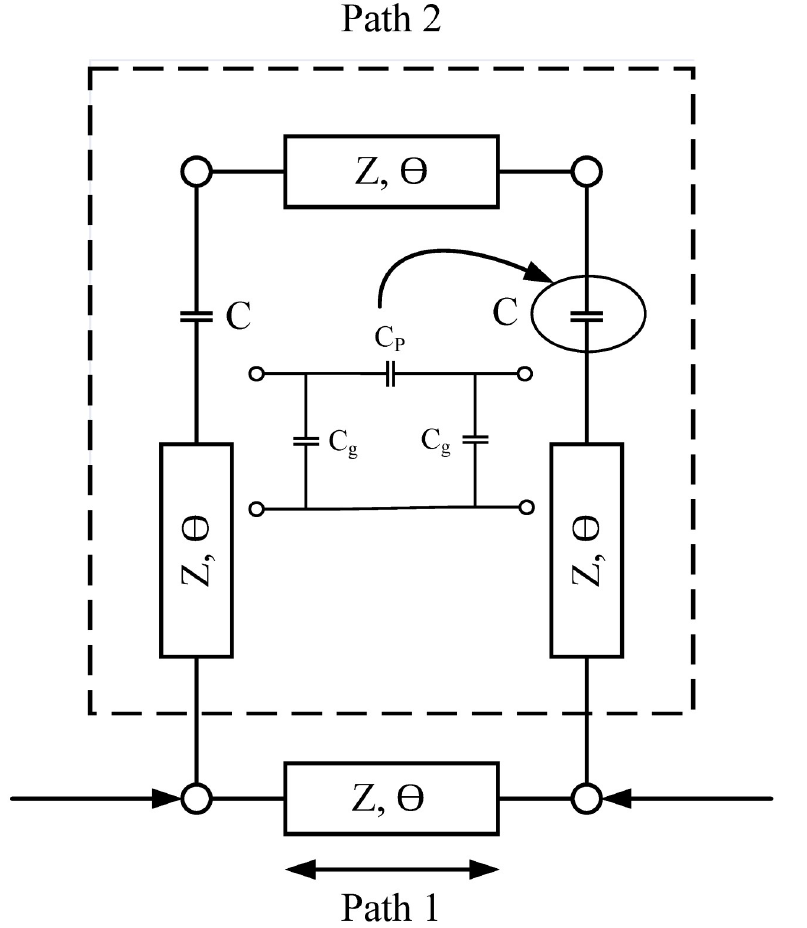
Fig 1. Schematic model of proposed